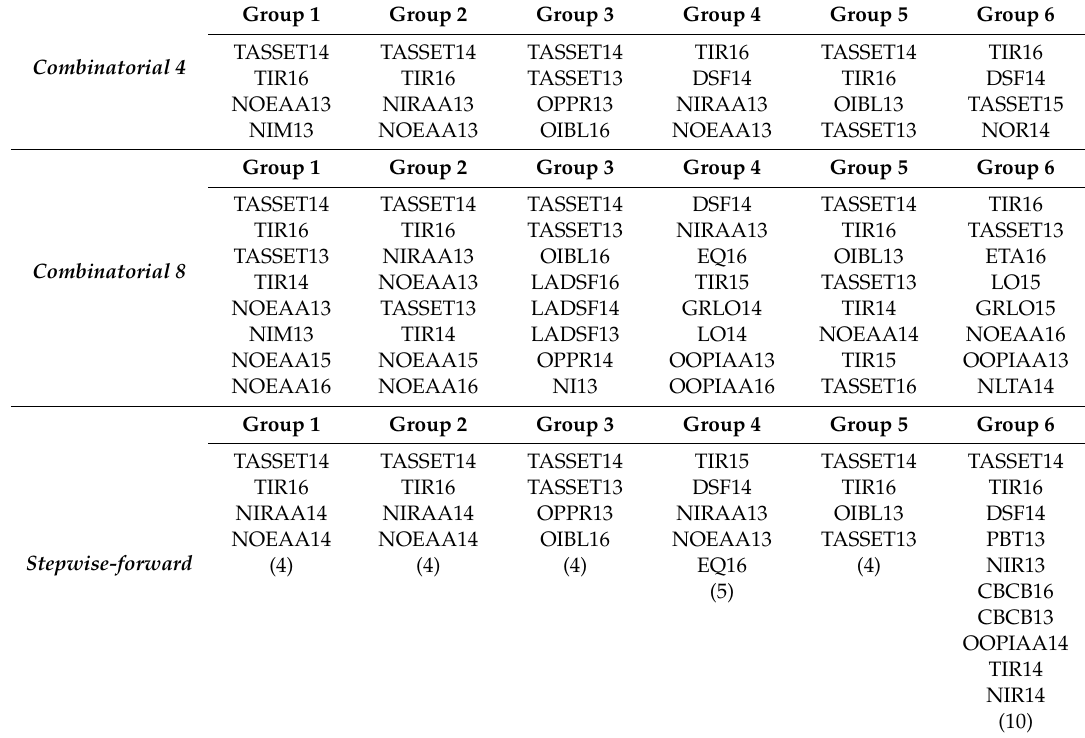
Table 4. Selected variables in each one of the 18